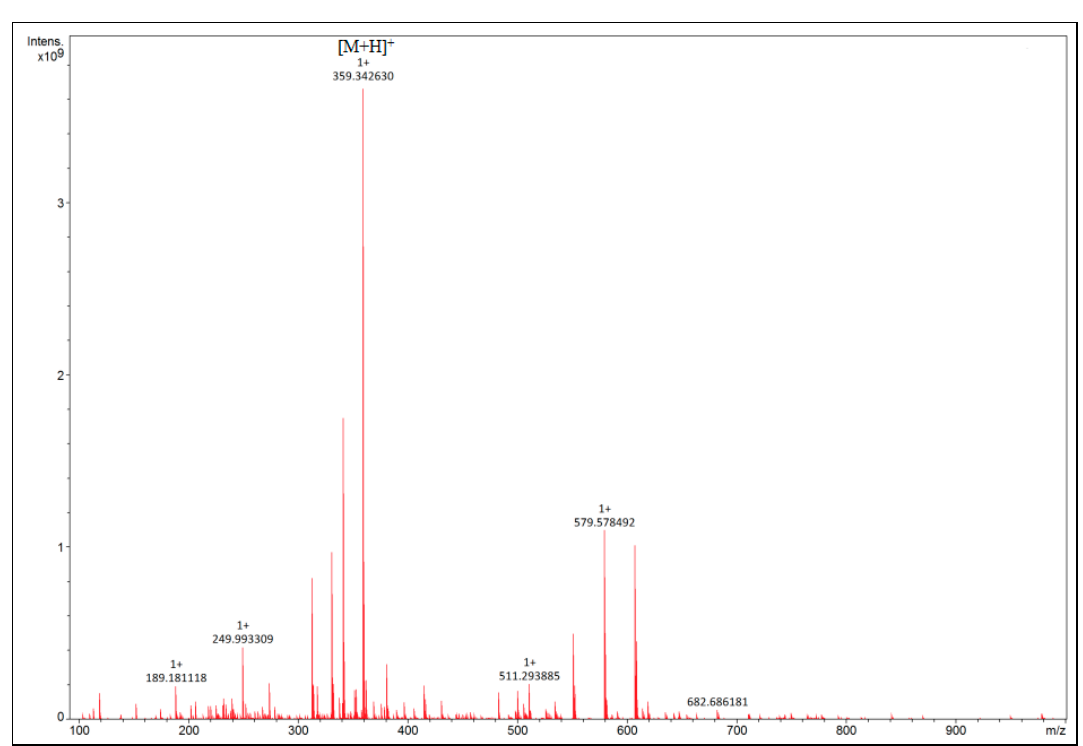
Figure 9. HR-MS analysis of Val-Ile-Lys peptide after cleavage from the MW-NPS-2-APS-HMBA nanostructured system (first screening before the MS-MS experiment).